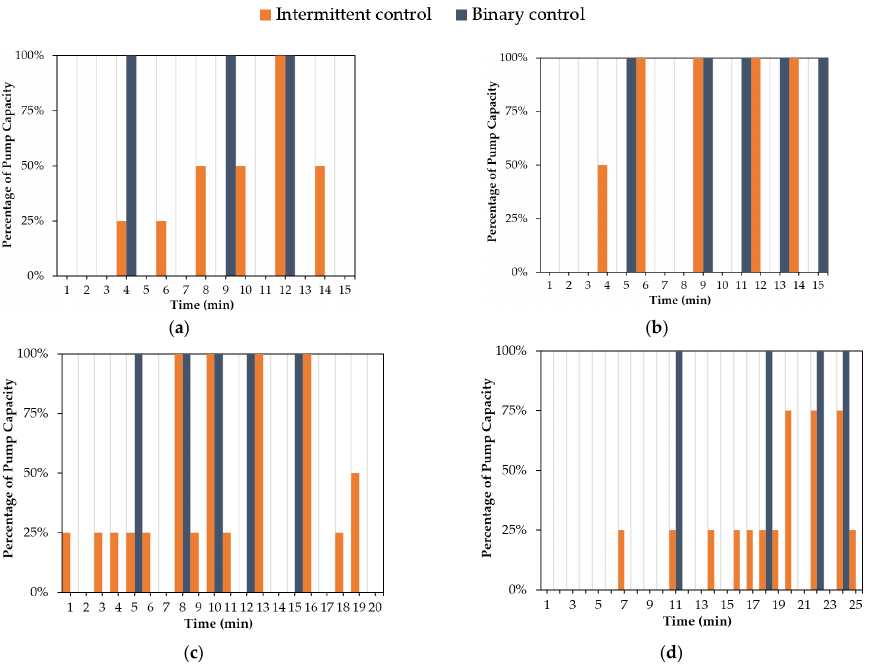
Figure 12. Selection of actions to regulate the pump’s flow rate using binary and intermittent control during rainfall events: ( a ) 15-min-constant; ( b ) 15-min-normal; ( c ) 20-min-descending; ( d ) 25-min-ascending.